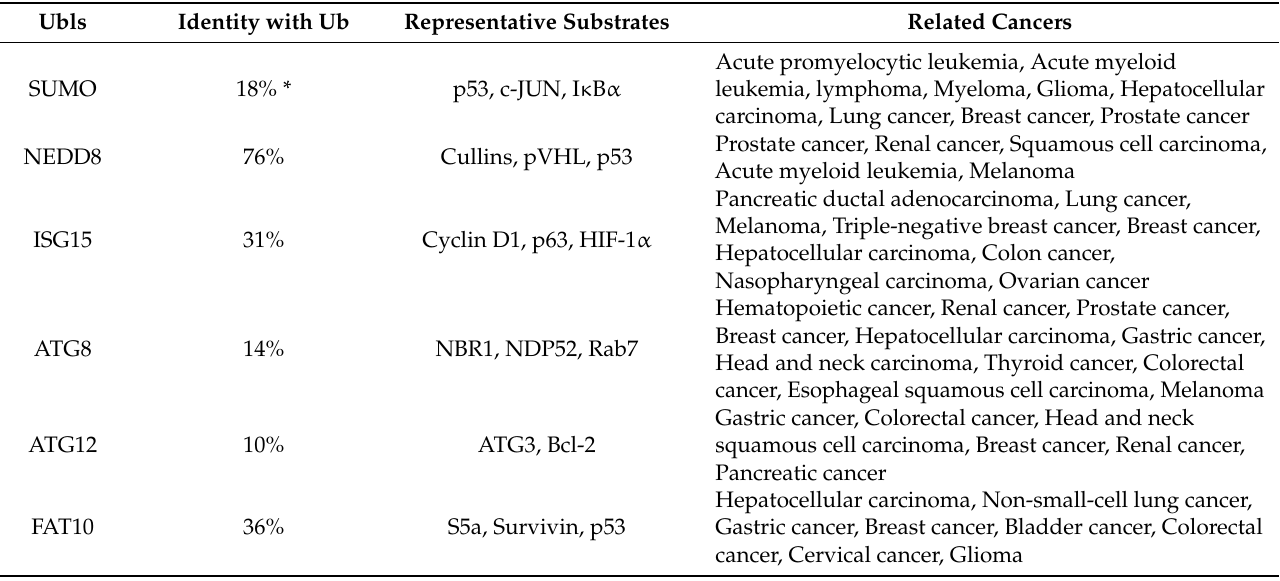
Table 1. Identity with Ub, representative substrates, and related cancers of